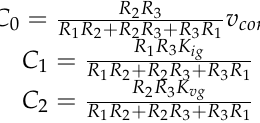
Figure 2. V-I and V-R characteristics for different illuminations.